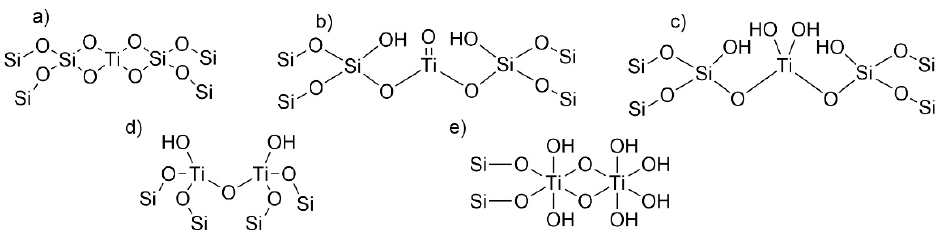
Figure 9. Possible methods of titanium binding in the Ti-MCM-14 catalyst: ( a ) Ti is bounded in the silica structure in the same manner as Si, ( b ) Ti is present in the form of Ti=O groups (titanyl groups), ( c ) Ti is present in the form of hydrated titanyl groups, ( d ) and ( e ) possible dimeric structures of titanium on the surface of the catalyst.